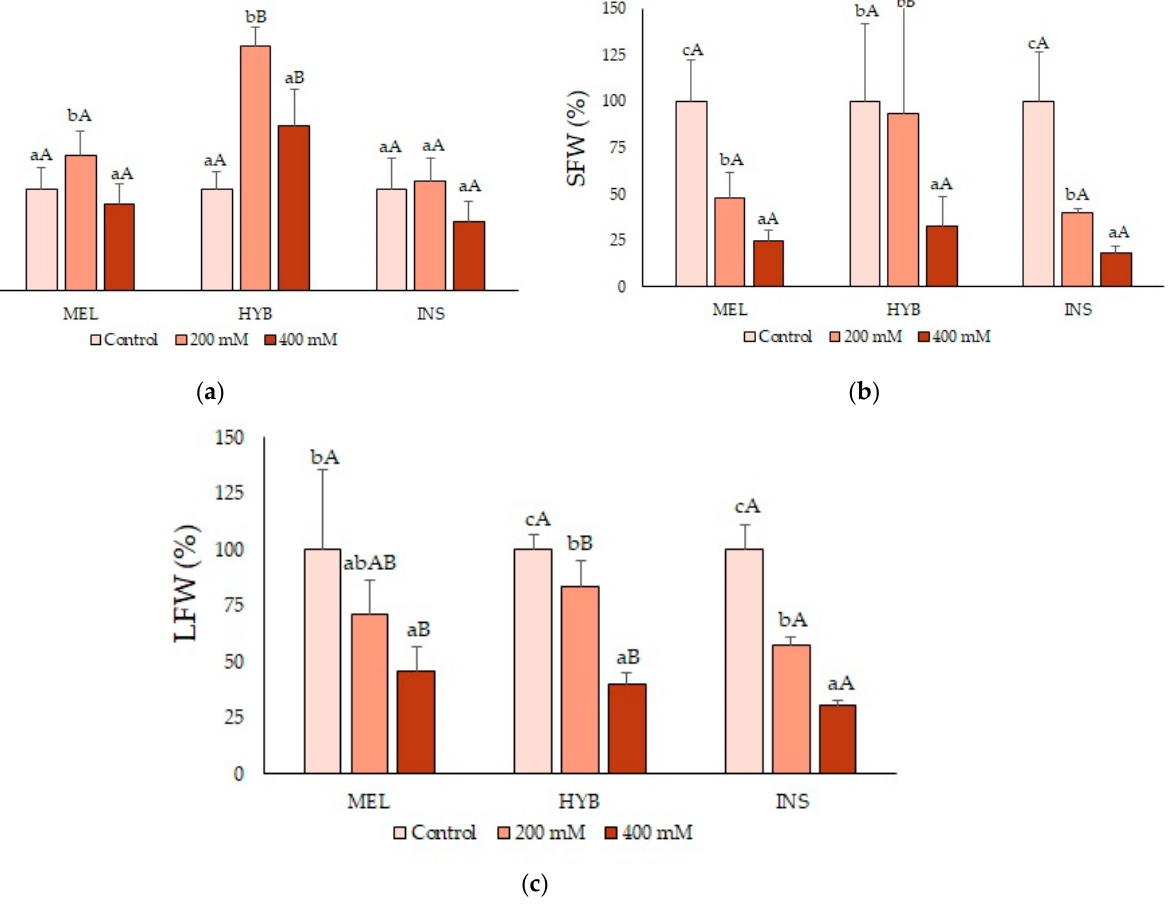
Figure 4. Root (RFW) ( a ), stem (SFW) ( b ) and leaf (LFW) ( c ) fresh weight in Solanum melongena (MEL), Solanum insanum (INS) and their hybrid (HYB) in the conditions tested (control 200 mM and 400 mM of NaCl, as indicated). Percentages (mean ± SD; n = 5) are referred to the control as the 100% with absolute values for RFW (g): [MEL = 13.3, HYB = 12.2, INS = 12.2], SFW (g): [MEL = 6.8, HYB = 7.7, INS = 7.4] and LFW (g): [MEL = 13, HYB = 13.1, INS = 16.2]. Different lowercase letters within the same genotype indicate statistically significant differences between treatments, and different uppercase letters within the same treatment indicate statistically significant differences between genotypes ( p < 0.05), according to the Student–Newman–Keuls multiple range test. Table 2. Root (RWC) ( a ), stem (SWC) ( b ) and leaf (LWC) ( c ) water content (%) (mean ± SD; n = 5) in Solanum melongena (MEL), Solanum insanum (INS) and their hybrid (HYB) in the conditions tested (control 200 mM and 400 mM of NaCl, as indicated). Different lowercase letters within the same genotype indicate statistically significant differences between treatments, and different uppercase letters within the same treatment indicate statistically significant differences between genotypes ( p < 0.05), according to the Student–Newman–Keuls multiple range test.